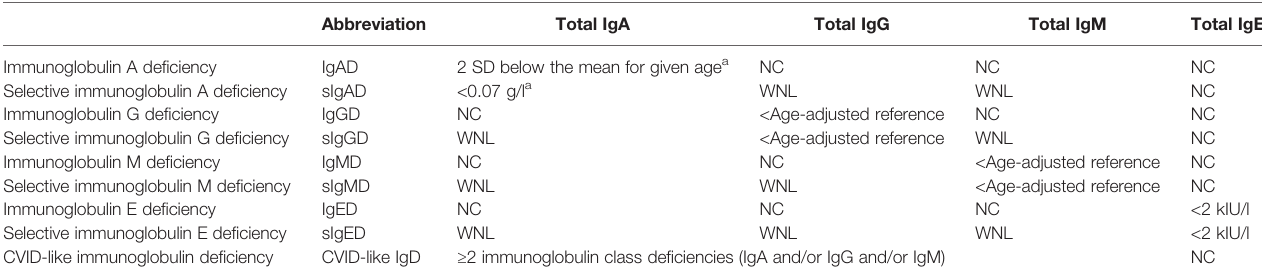
TABLE 1 | Immunoglobulin de fi ciency categories considered in the study a